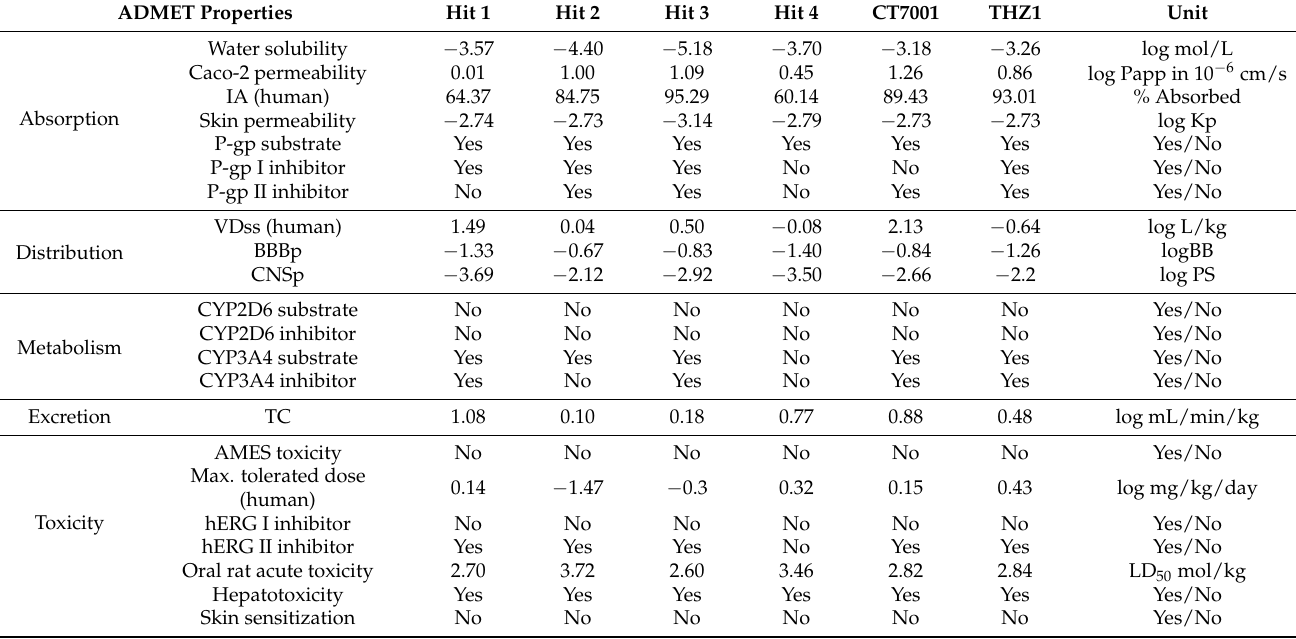
Table 5. In silico prediction of ADMET properties for reference inhibitors and identified